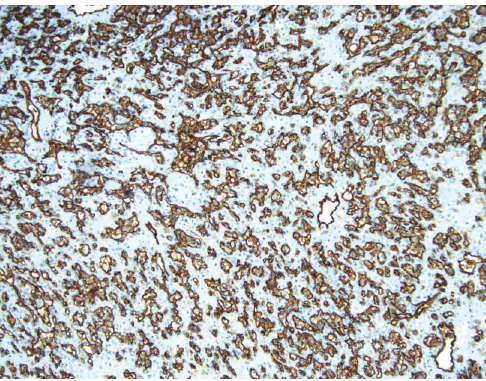
Figure 4: A CD31 immunostain clearly highlights the vascular spaces and the lining tumor cells (DAB chromogen, medium power).